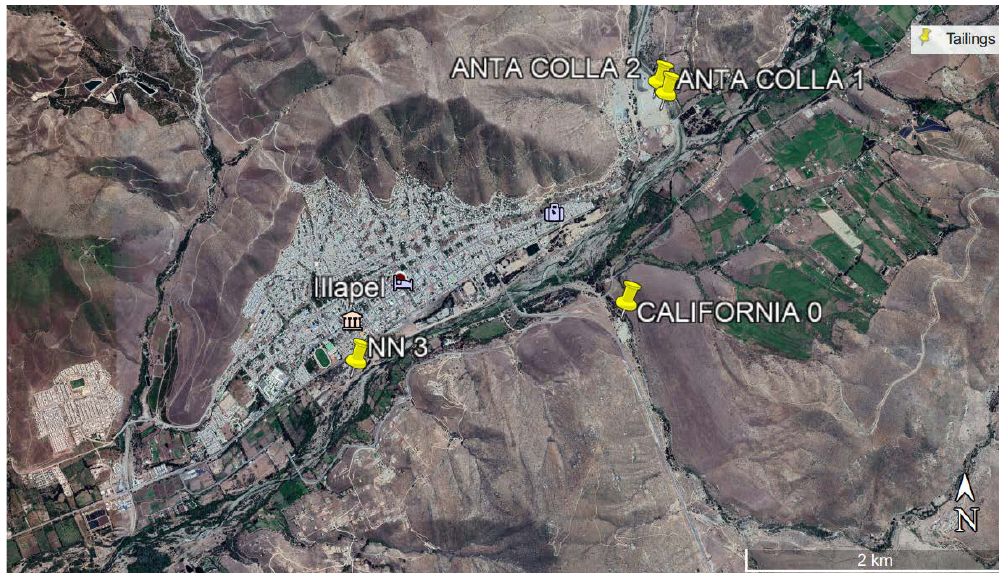
Figure 8. Tailings showing extremely high risk, according to Hakanson’s methodology [14].